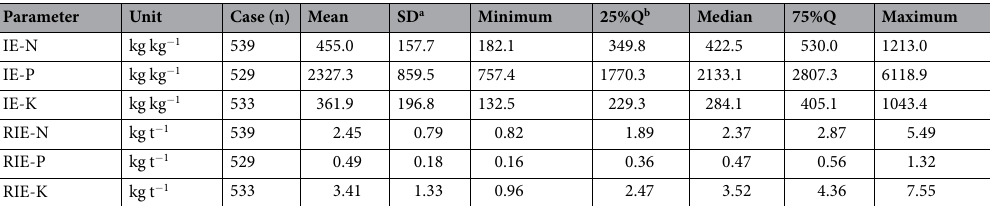
Table 3. Descriptive statistics of the internal efficiency of N, P, and K (IE, kg fleshy root per kg nutrient) and its reciprocal internal efficiency (RIE, kg nutrient per 1000 kg fleshy root) for radish grown in China. a SD, standard deviation. b Q,